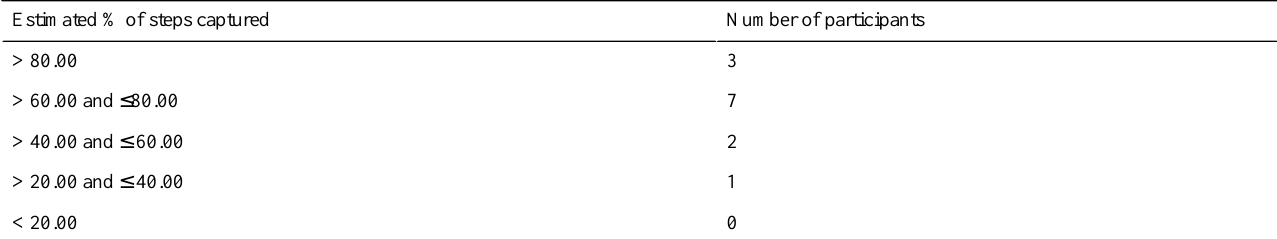
Table 5. Percent of steps captured using PersonA.